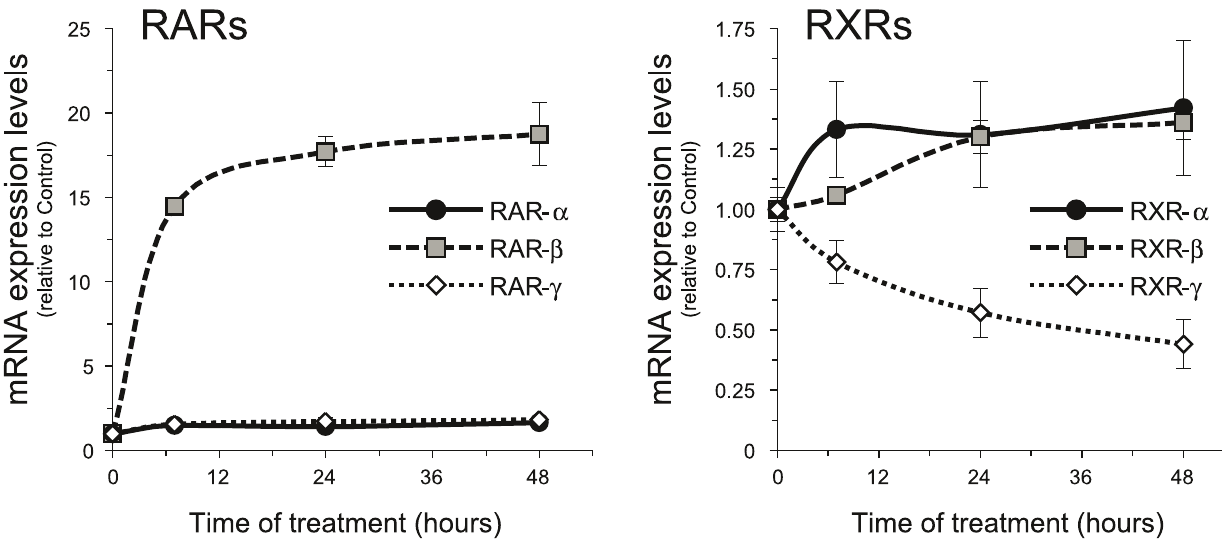
Figure 5. RA upregulates RAR- b mRNA and downregulates RXR- c mRNA in isolated SCs . SCs were treated with 1 m M RA for the times indicated and the relative levels of all six retinoid receptors were determined by Q-RT-PCR. All values are shown as the mean 6 SD relative to their respective controls.